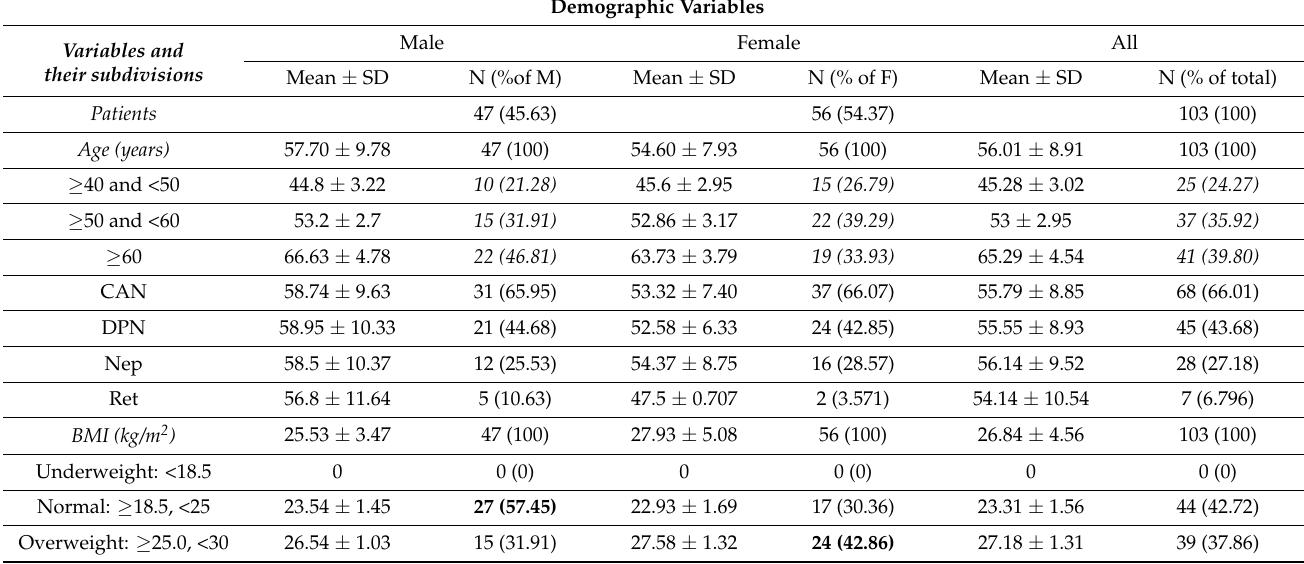
Table 3. Demographic and clinical variables of